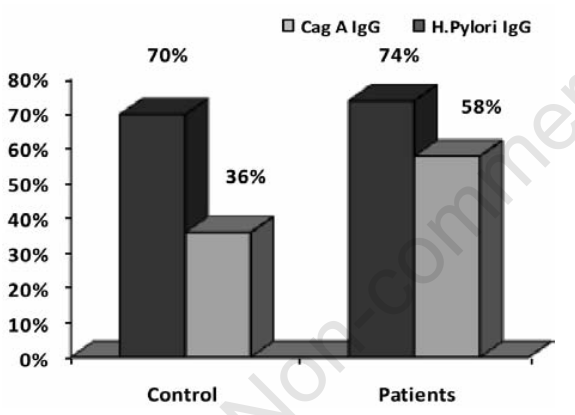
Figure 1. Prevalence of H. pylori and cytotoxin associated gene A, Immunoglobulin G seropositivity in controls and patients.